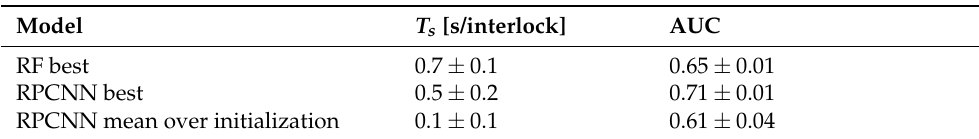
Table 7. Beam time saved ( T s ) and AUC results of the best-performing RF and RPCNN models over re-sampling of the validation sets.